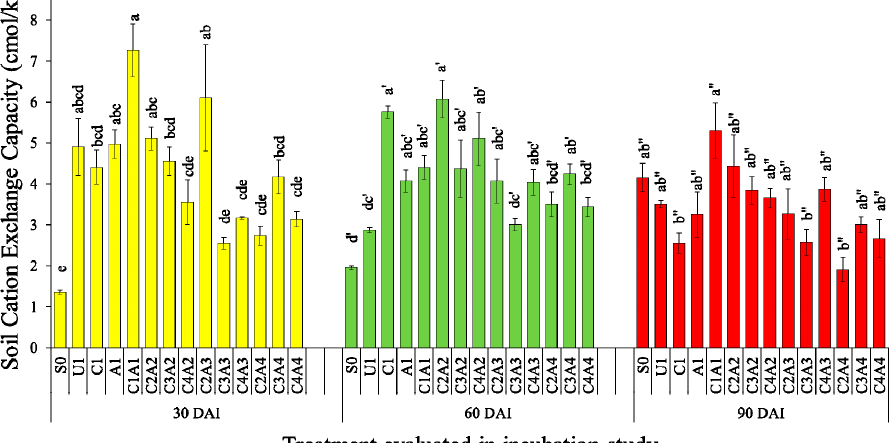
Figure 7. Treatments on soil cation exchange capacity after thirty, sixty, and ninety days of incubation. Means with different letter(s) within the same incubation period indicate significant difference between treatments by Tukey’s HSD test at p ≤ 0.05. Bars represent the mean values ± SE.